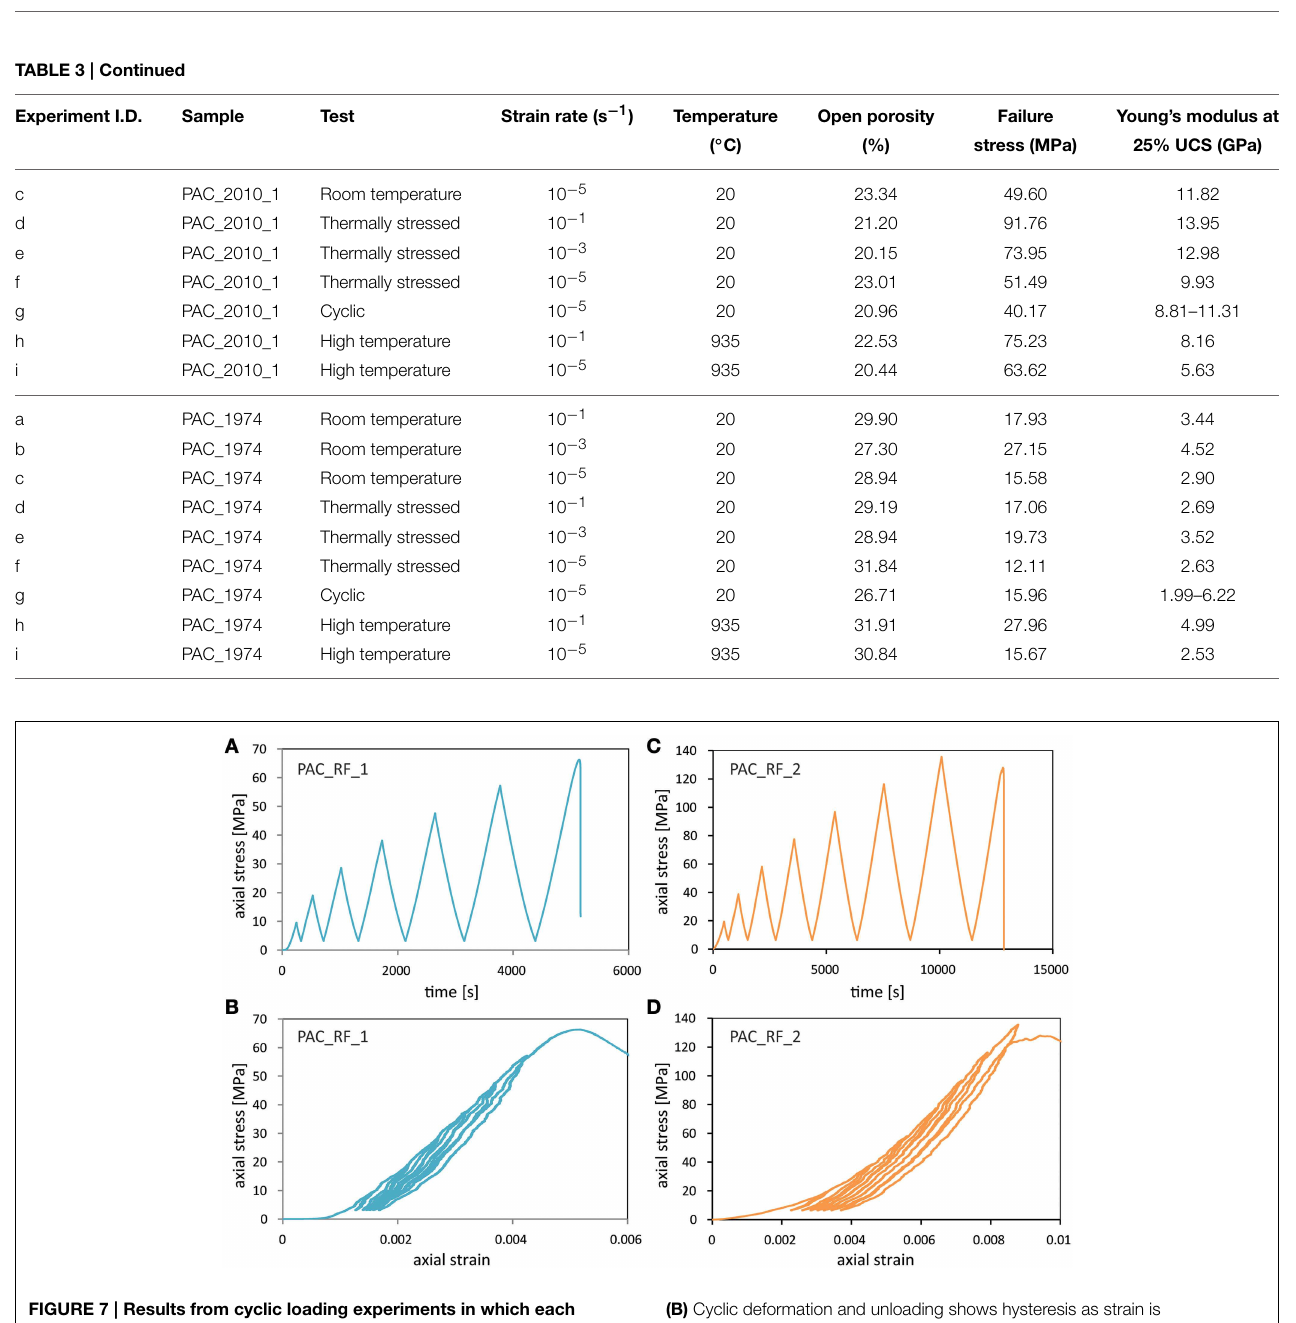
FIGURE 7 | Results from cyclic loading experiments in which each cycle reaches higher stress increments (set to 15% of the UCS) and is unloaded to 5% of the UCS between each cycle. Evolution of axial stress through time (A, C) and strain (B, D) . (A) During cyclic loading of sample PAC_RF_1 deformed at 10 − 5 s − 1 failure is achieved in the final cycle at a stress exceeding the stress value reached in the previous loading cycle.